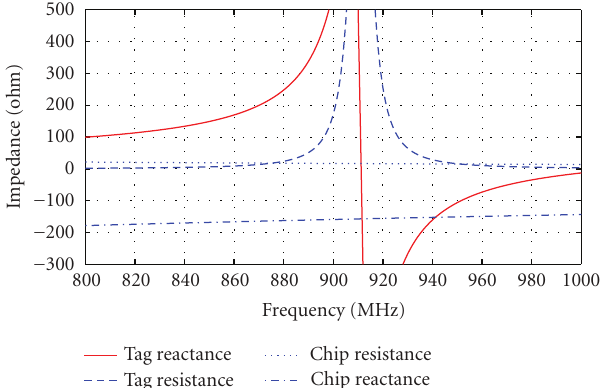
Figure 11: Measured threshold transmitted power in + z direction of the tag antenna, with 15% and 25% of BaTiO 3 concentration in the composite substrates.